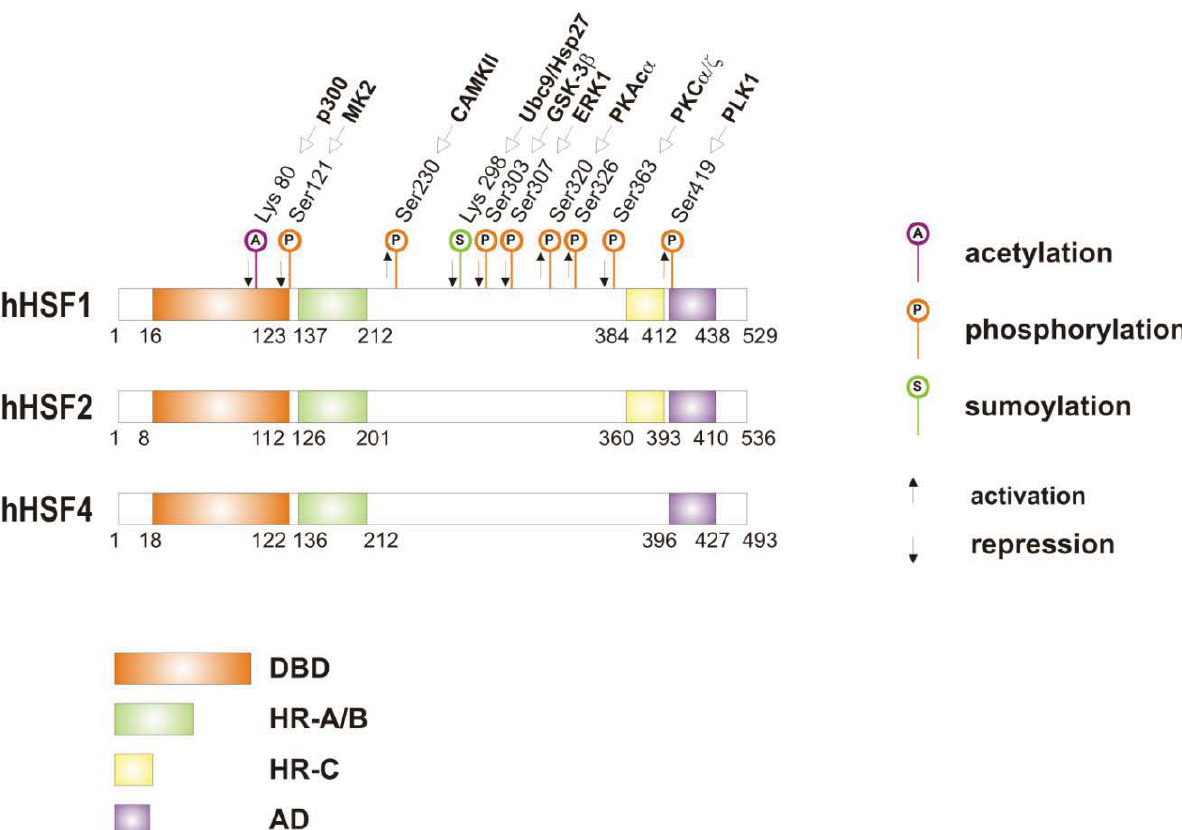
Figure 2. Structural and regulatory features of HSFs. Schematic view of human HSFs structural motifs, corresponding to: DNA binding domain (DBD); hydrophobic heptad repeats (HR-A/B and HR-C); activation domain (AD). The relative position of these domains in HSF1, HSF2 and HSF4 are described by the amino acid residues and by diverse colors. Major HSF1-related post-translational modifications (PTMs) are also indicated, with sites for acetylation (A), phosphorylation (P) and sumoylation (S) distinguished by their contribution to the transactivation function of the protein (activation=↑;